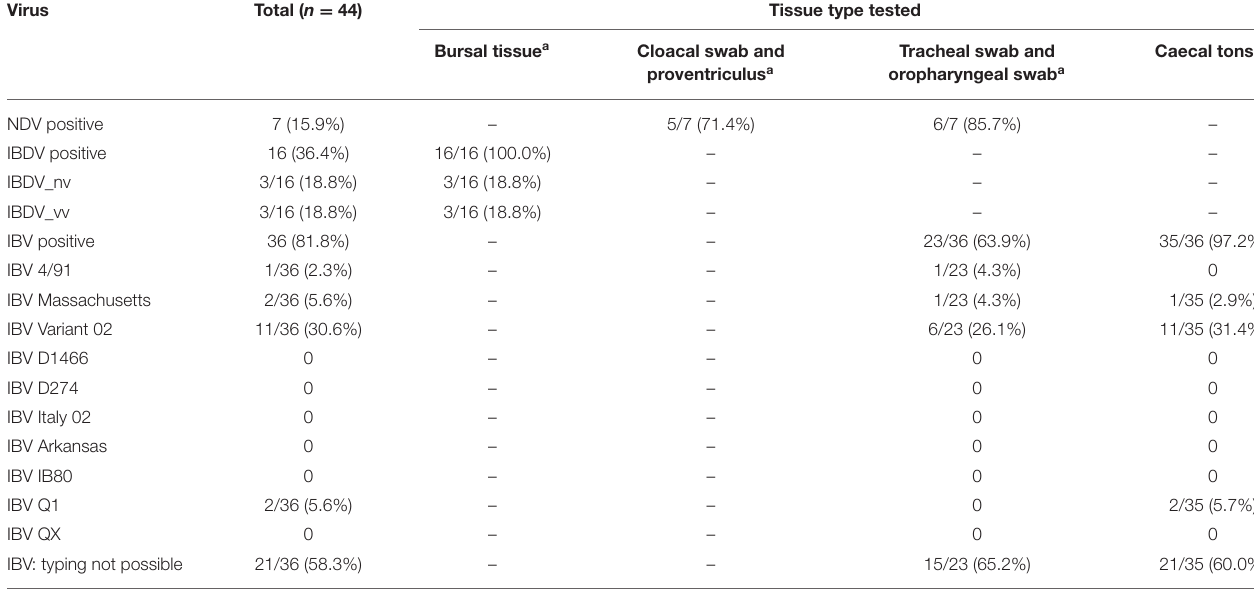
TABLE 4 | rRT-PCR results by tissue type